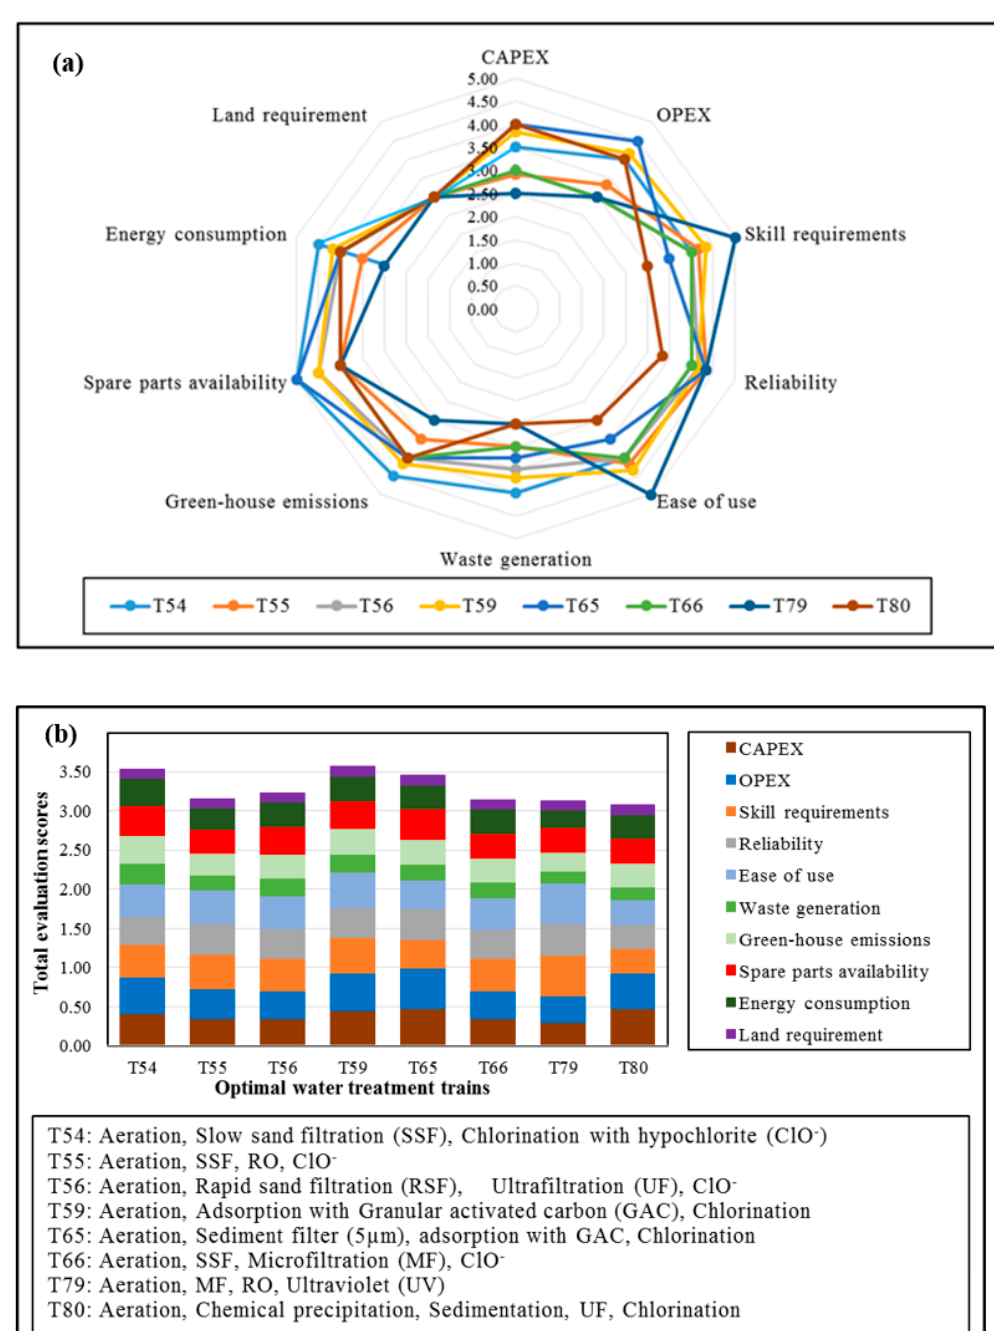
Figure 2. Results of Scenario 1—drinking water treatment systems for Srirangapatna: ( a ) Criteria/objective contribution star chart; ( b ) Stacked column on performance of water treatment systems.